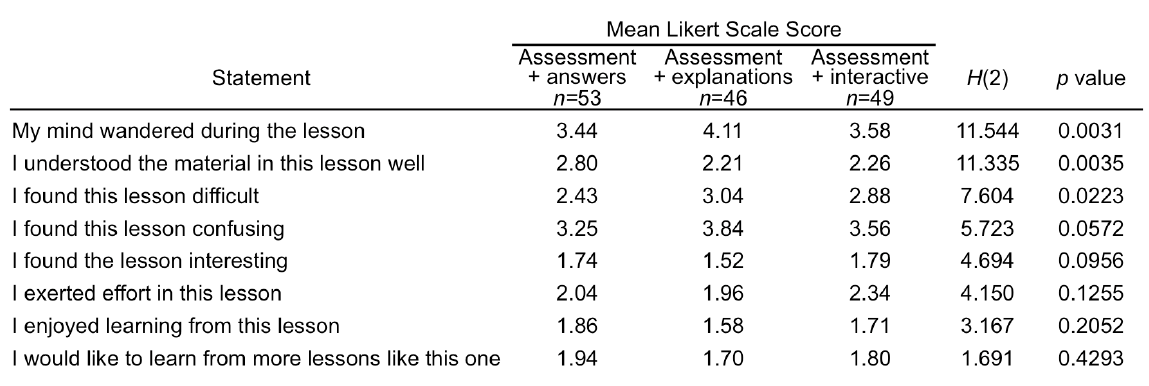
Summary of Survey Responses for Assessment